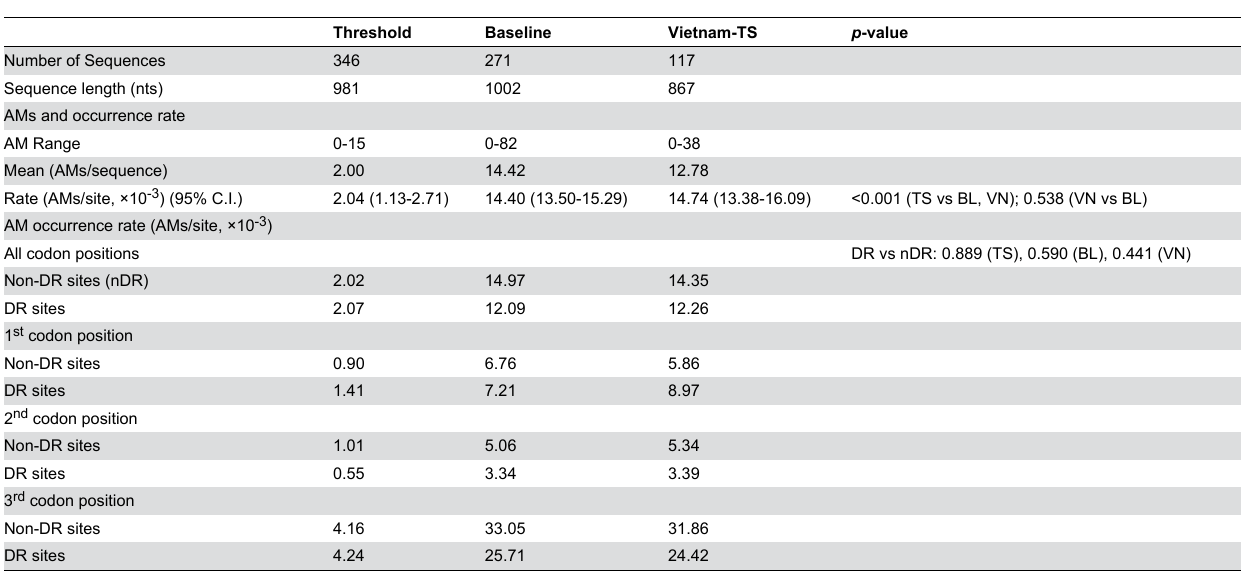
Table 2. Characteristics of ambiguous mutations (AMs) and rates between threshold and baseline sequence